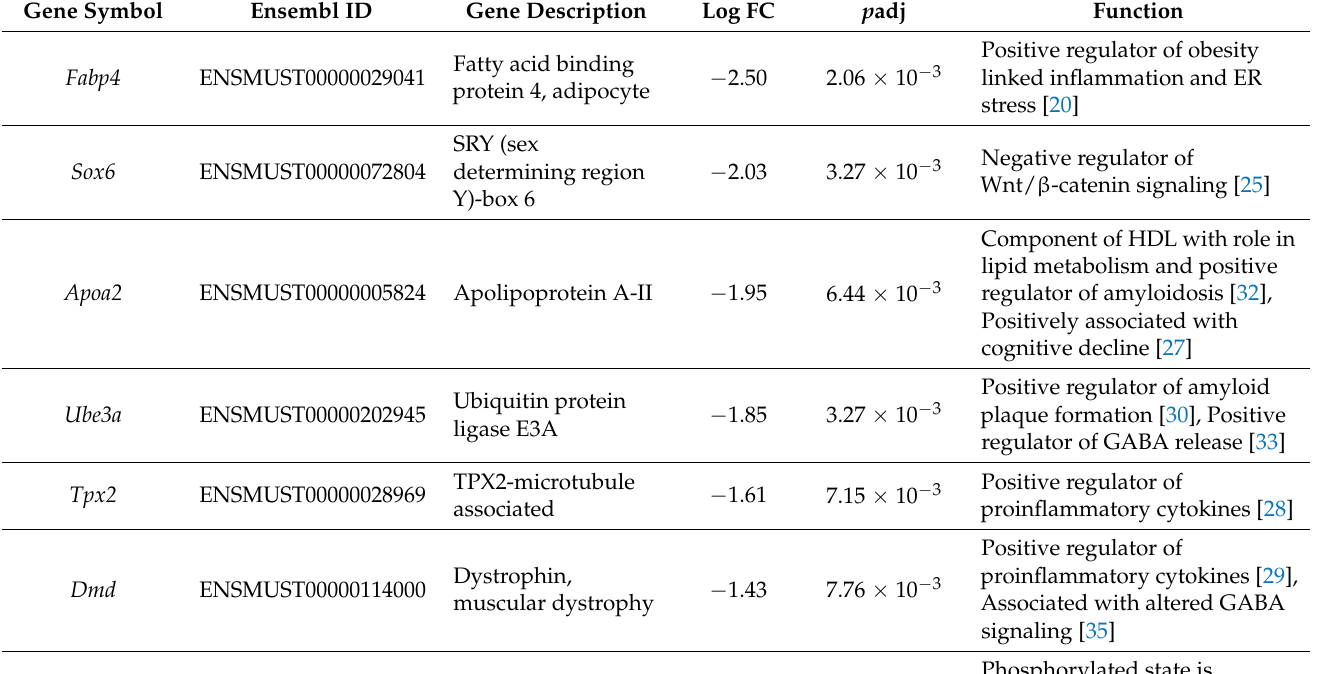
Table 1. Downregulated Transcripts in HFD-fed AKO Compared to HFD-fed WT Mice. Transcripts with LFC ≤ − 1.00 and p adj ≤ 0.001 are displayed. Gene symbol, Ensembl ID, gene description, log fold change (log2), log10 adjusted p -value, and relevant known function are